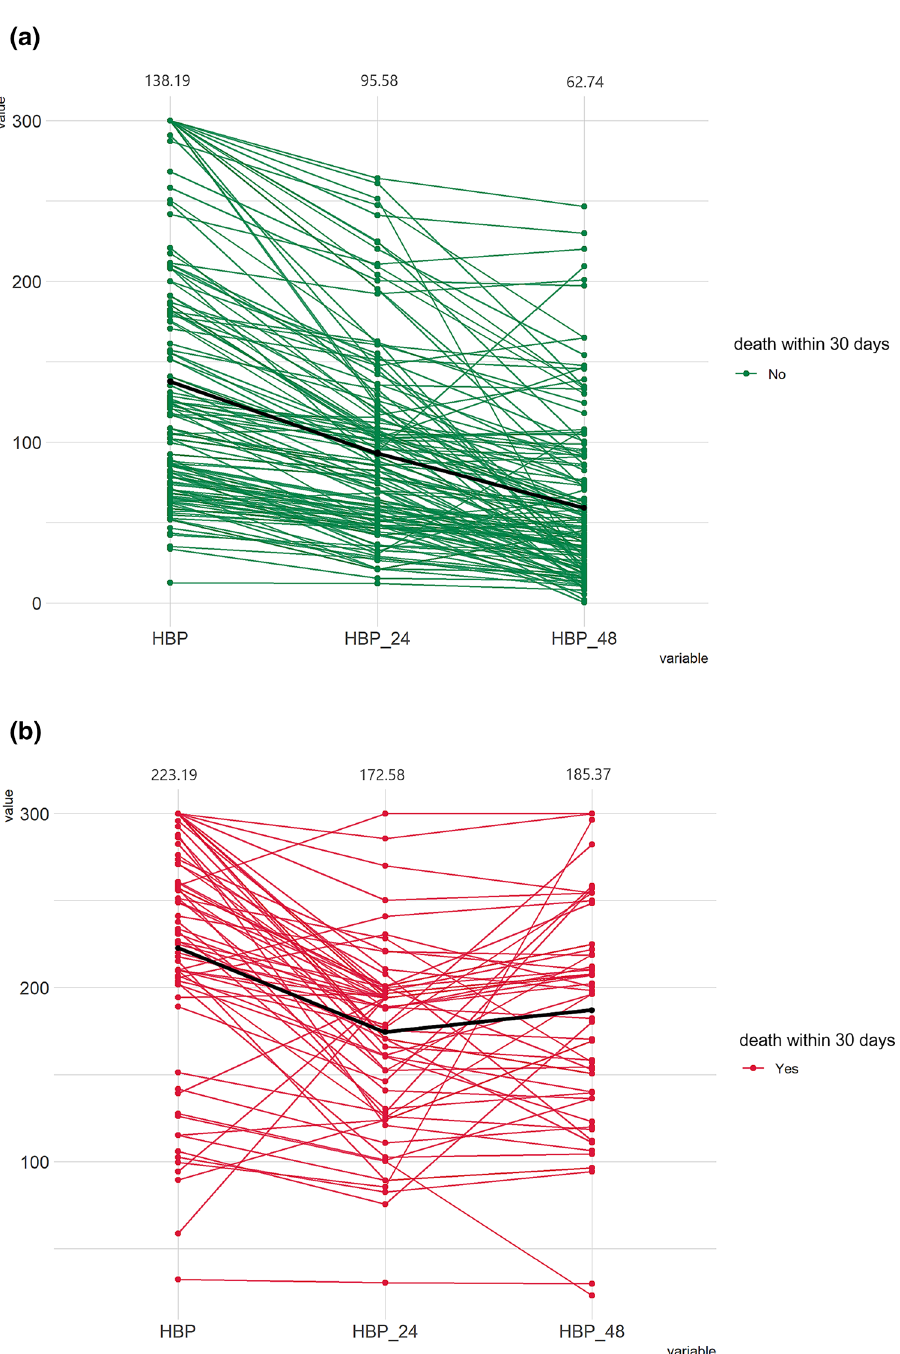
Figure 2. Serial measurement of plasma levels of HBP between sepsis survivors ( a ) and nonsurvivors ( b